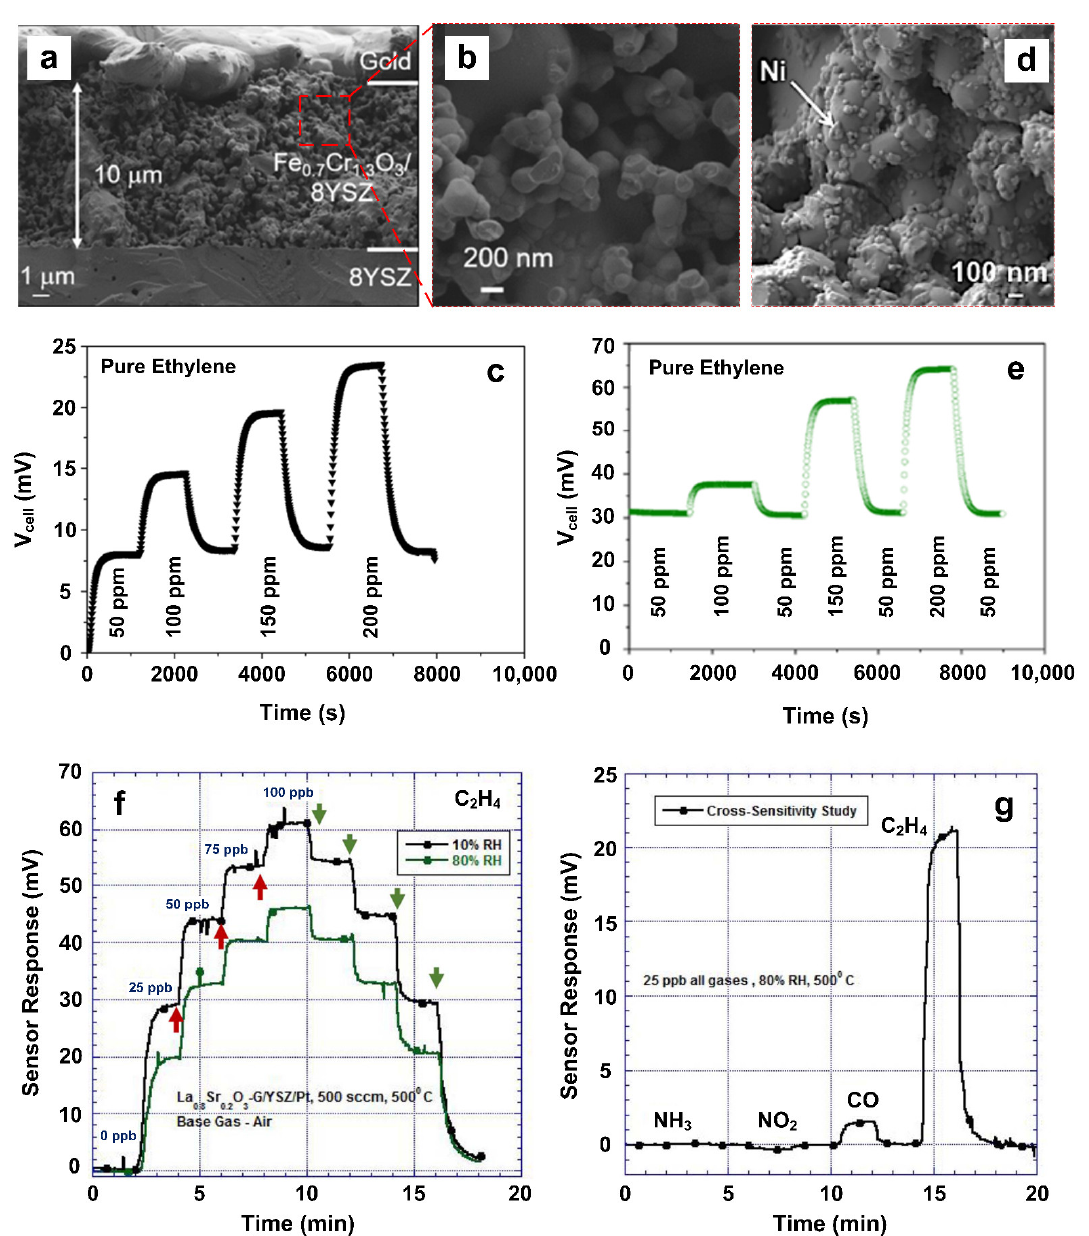
Figure 5. ( a ) Cross-sectional image of the potentiometric ethylene gas sensor; ( b ) magnified SEM image of the rectangular cycle. ( c ) The dynamic response curve of ethylene gas detection at different concentrations. Reproduced from Ref. [43] with permission from the MDPI AG. ( d ) SEM image of the modified potentiometric sensor with incorporated Ni nanoparticles. ( e ) The improved response curve of the modified potentiometric sensor to ethylene gas at varied concentrations. Reproduced from Ref. [44] with permission the American Chemical Society. ( f ) The ethylene-sensing performance of rGO–Cu composited potentiometric gas sensor toward ppb-level ethylene gas at low (10 RH%) and high (80 RH%) wet conditions. The onset of increase and decrease in ethylene concentrations are indicated by the upward (red) and downward (green) arrows accordingly. ( g ) The sensing response toward different 25 ppb gases at 80 RH% condition. Reproduced from Ref. [45] with permission the Electrochemical